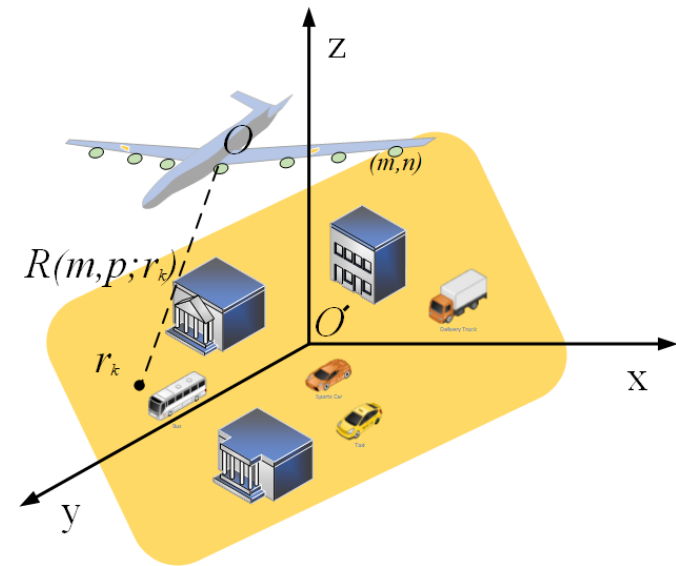
Figure 1. The geometric relationship of target